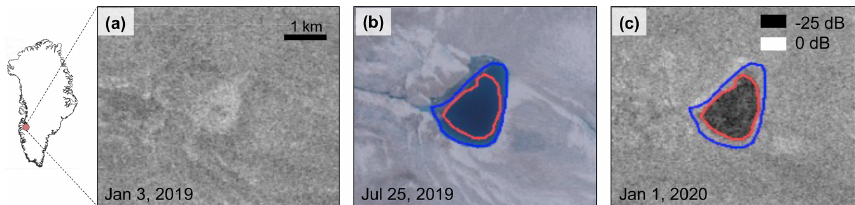
Figure 8. Chronological S1 (greyscale) and S2 (true colour) images of a buried lake detected in SW Greenland in the winter following the 2019 melt season. (a) S1 image from 3 January 2019 with no buried lake detected. (b) S2 image from 25 July 2019 with surface lake extent outlined in blue and post-melt season buried lake extent outlined in red. (c) S1 image from 1 January 2020.